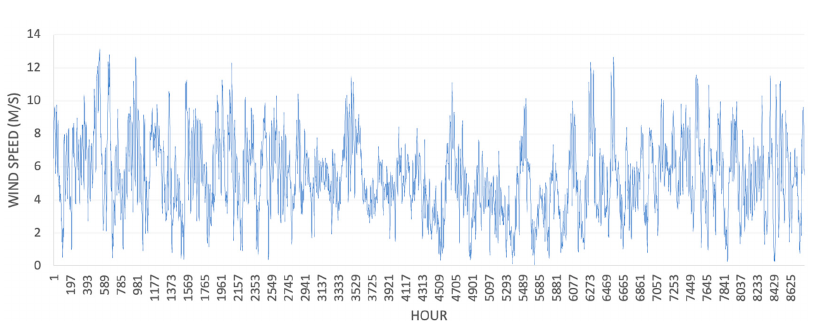
Figure 4. Hourly direct solar irradiance (kW/m 2 ) and wind speed measurement (m/s) in 50 m hub height for 2019 in Isla de la Juventud. Source: [44,45].